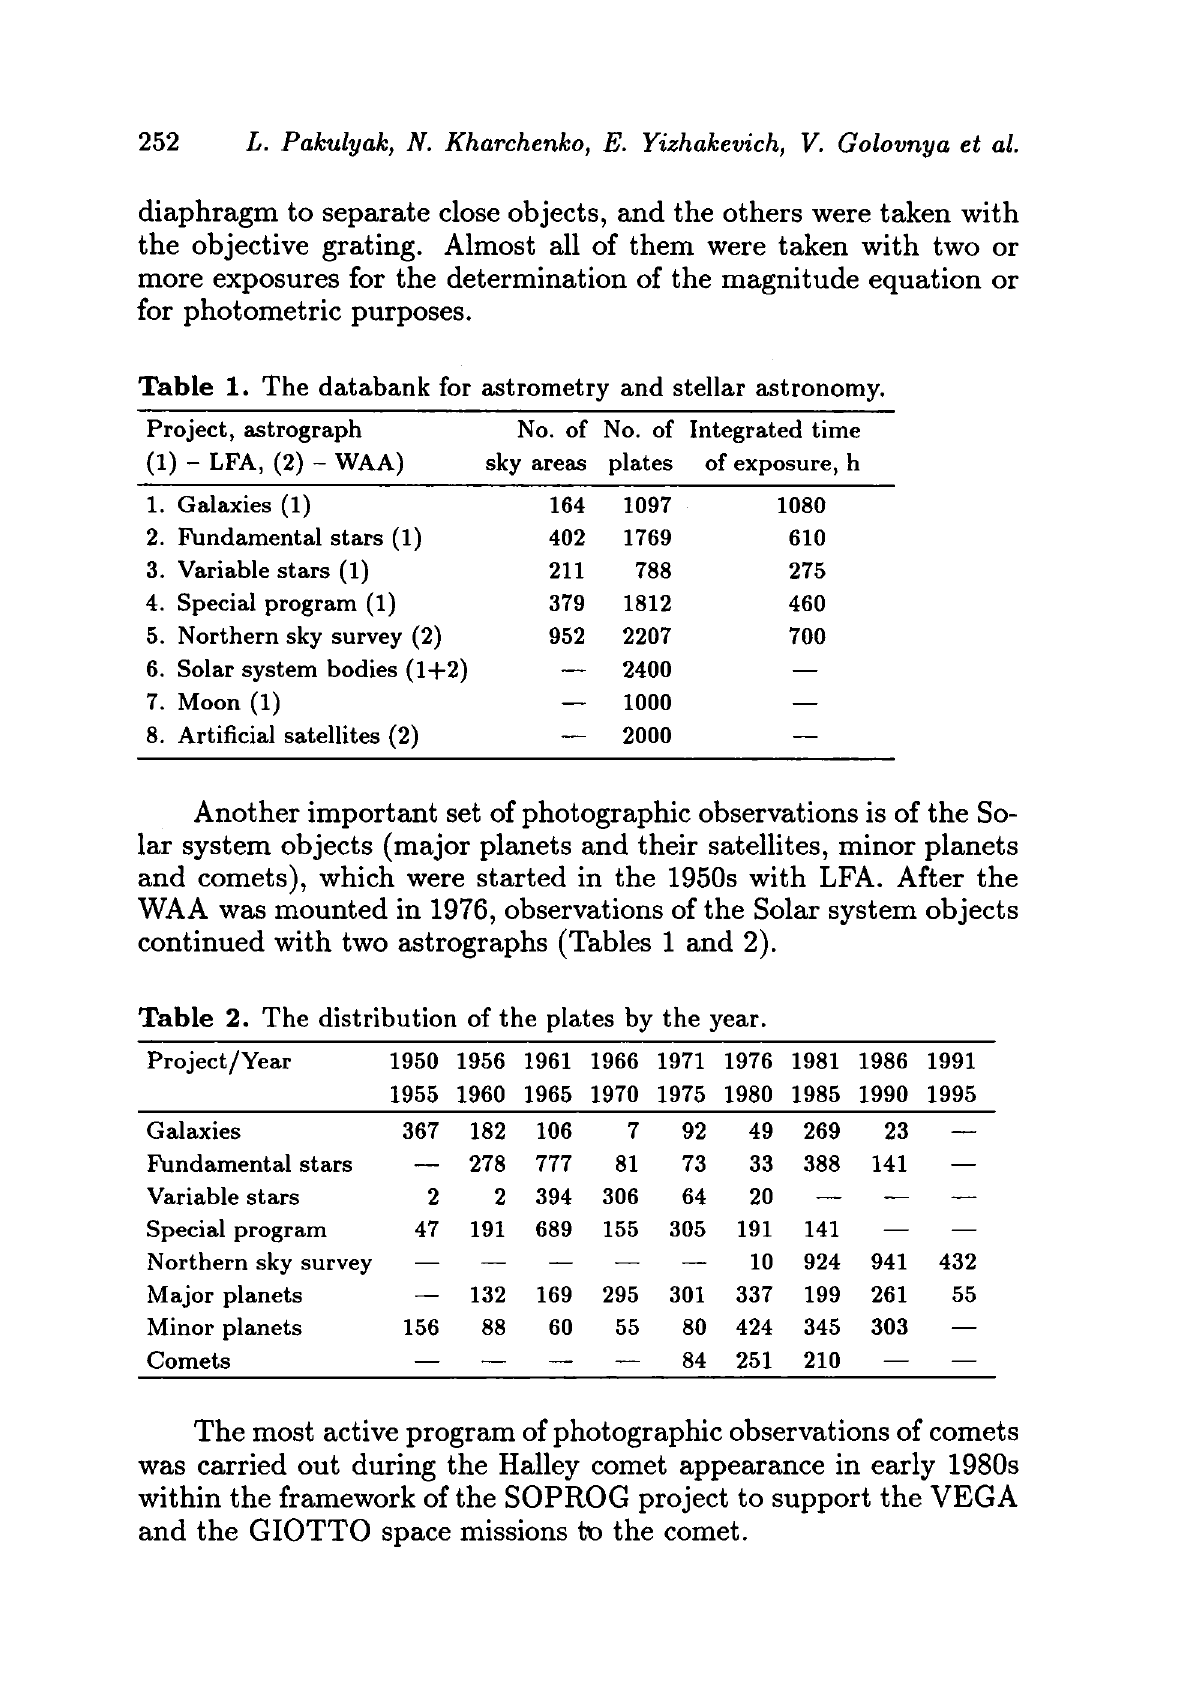
Table 1. The databank for astrometry and stellar astronomy. Project, astrograph